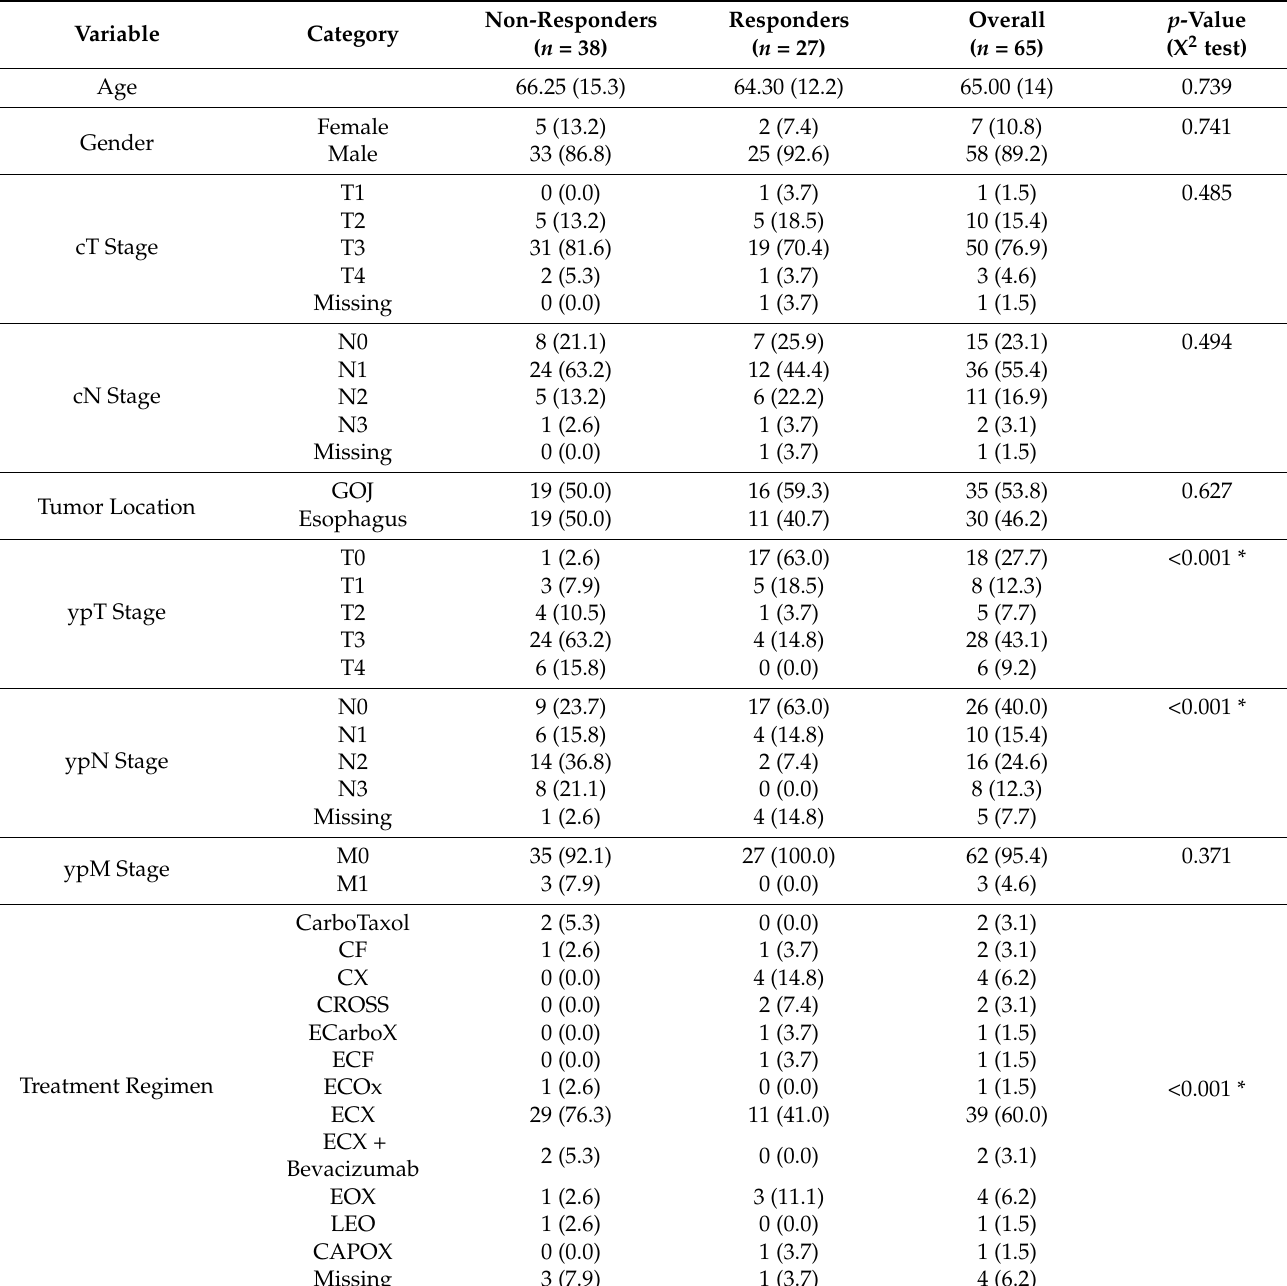
Table 1. Clinicopathological data for the study cohort according to response to